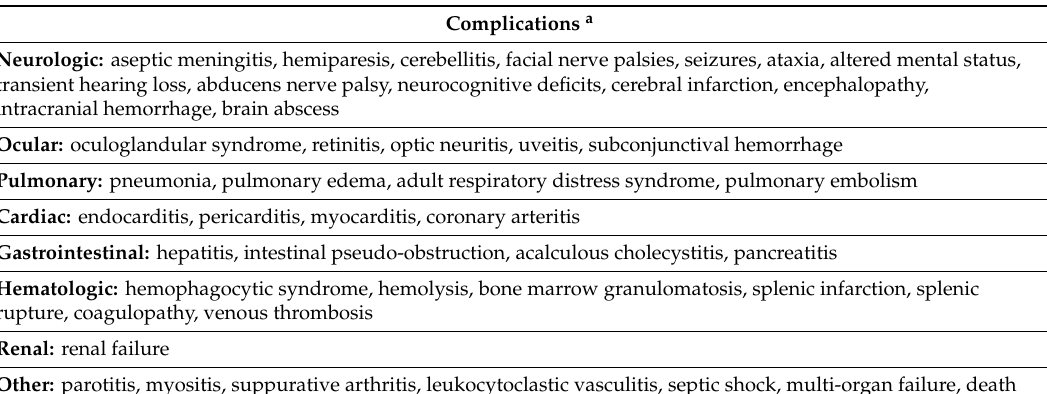
Table 1. Reported complications of flea-borne